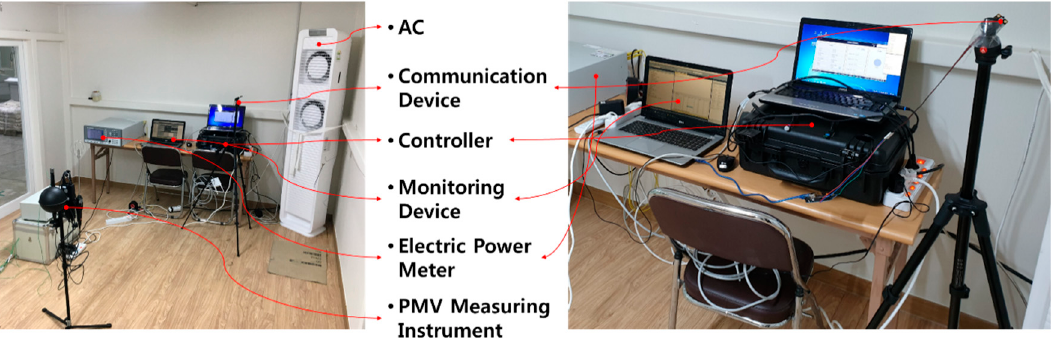
Figure 13. Air conditioner (AC) unit, TCC-V1, PMV meter installation status in the inner chamber.